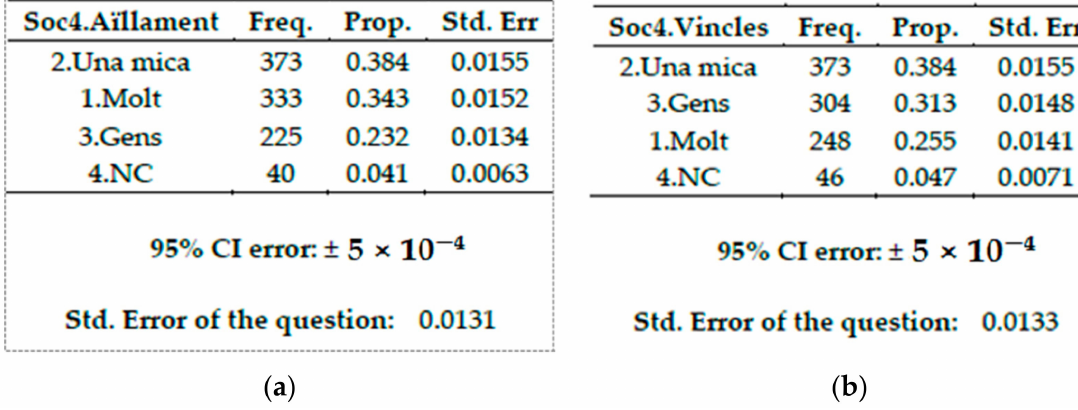
Figure 38. ( a ). Frequency table of isolation feelings during pandemics ( b ) Frequency table of intensification of links due to